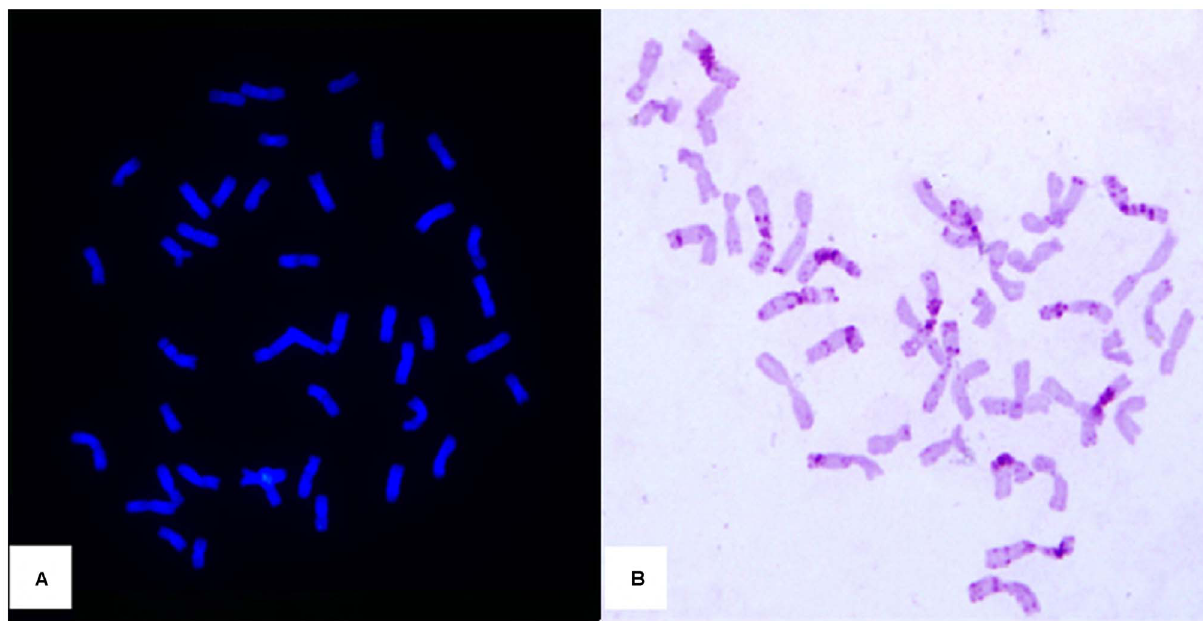
Figure 1. Cytogenetic analysis of CH7086. A) GISH patterns of CH7086 using Th. ponticum genomic DNA (labeled with fluorescein-12-dUTP) as probe. Cell was counterstained with DAPI and fluoresces blue. No GISH signal was observed in CH7086. B) Giemsa-C banding of CH7086.